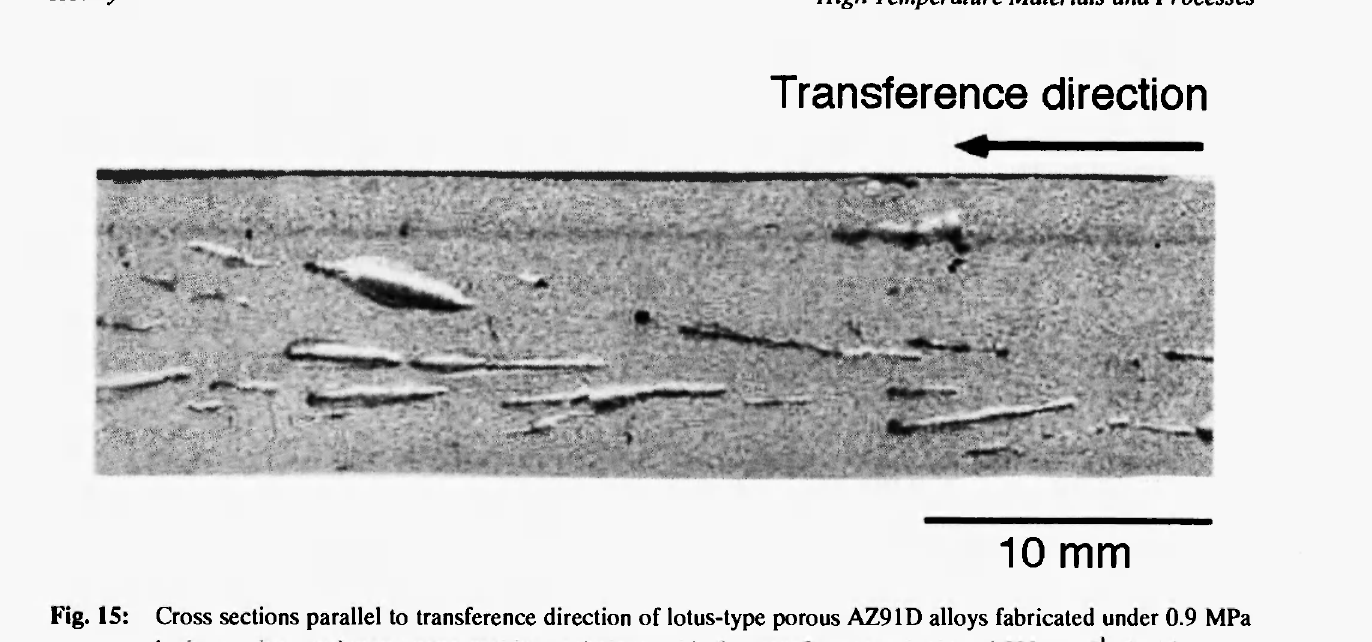
Fig. 15: Cross sections parallel to transference direction of lotus-type porous AZ91D alloys fabricated under 0.9 MPa hydrogen by continuous zone melting technique with the transference velocity of 500 μιτ«"'. Ambient gas was blown to the portion of the sample rod right below the heated zone using an electric fan with electric voltage of 100